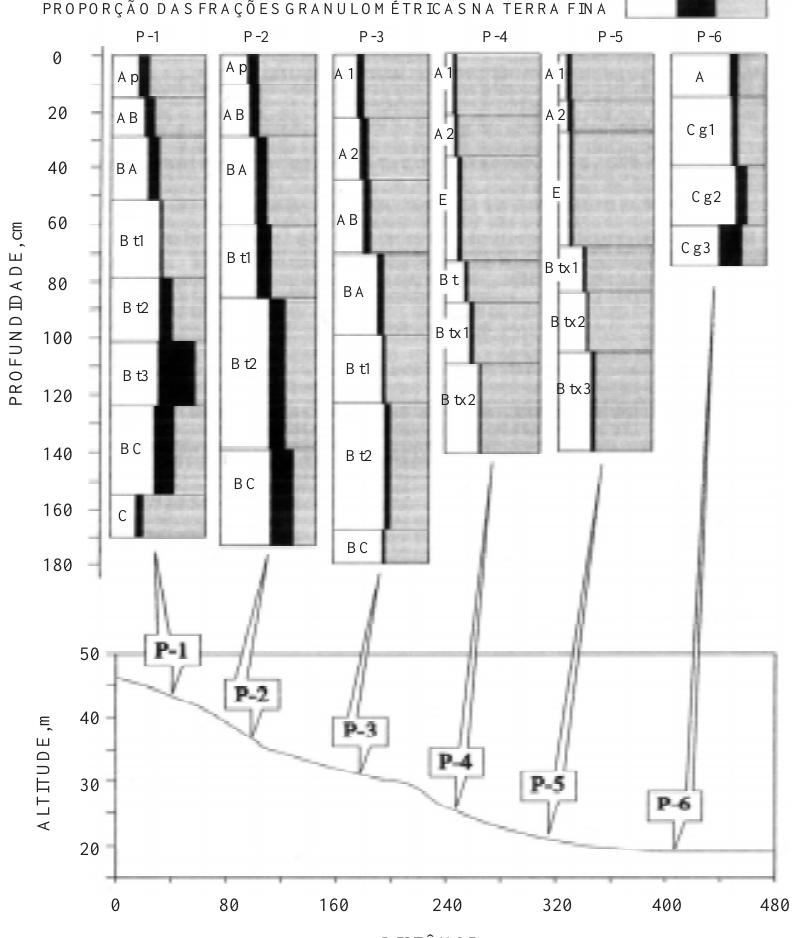
Figura 1. Localização dos perfis na toposseqüência e distribuição das frações granulométricas em profundidade. A escala no canto superior direito indica o padrão usado para representar a proporção dos componentes areia, silte e argila, em cada horizonte e perfil de